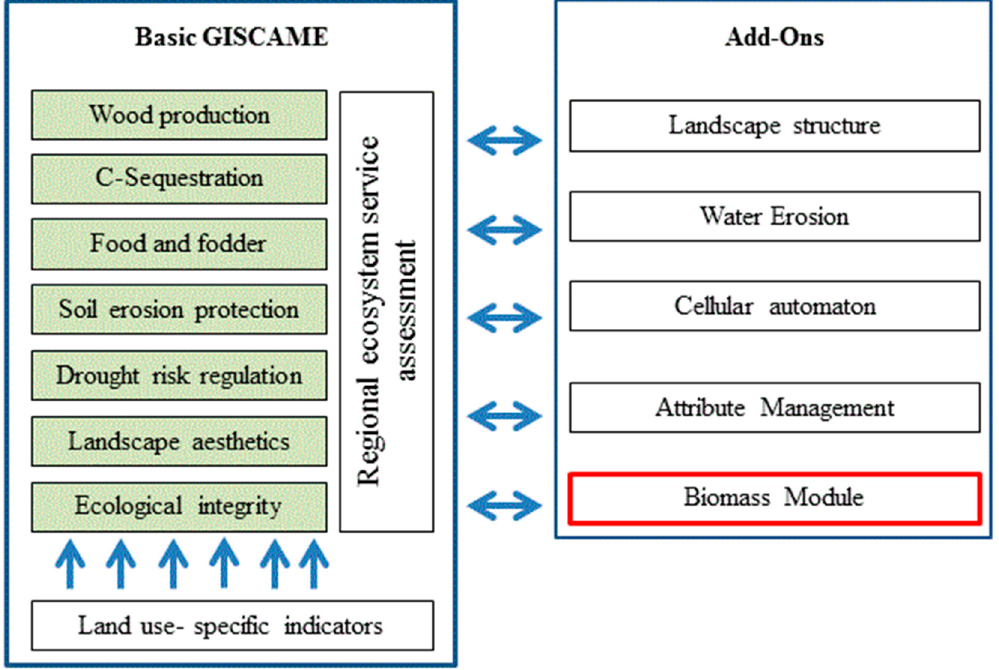
Figure 2. Overview of the main components of GISCAME. In addition to the basic land use type-specific ecosystem services assessment (left side), add-ons facilitate in-depth analyses (right side). The Biomass Module is introduced and applied in the study at